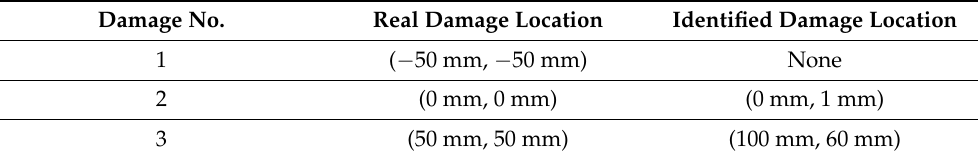
Table 2. Comparison of identified and real damage locations of three damage cases.